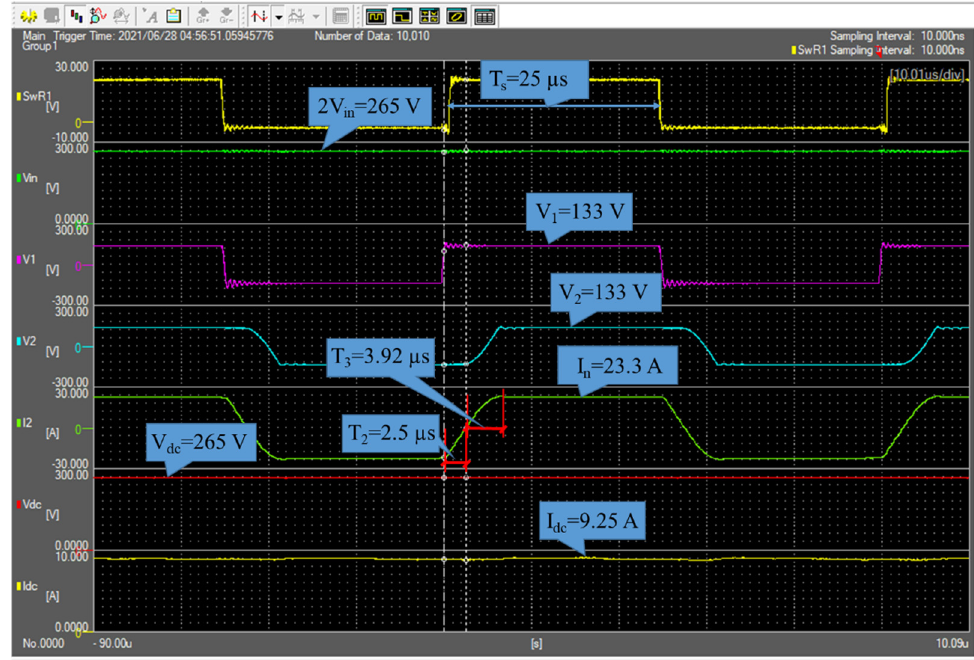
Figure 9. Experimental voltage and current waveforms at 𝑓 (cid:3046) = 20 kHz .